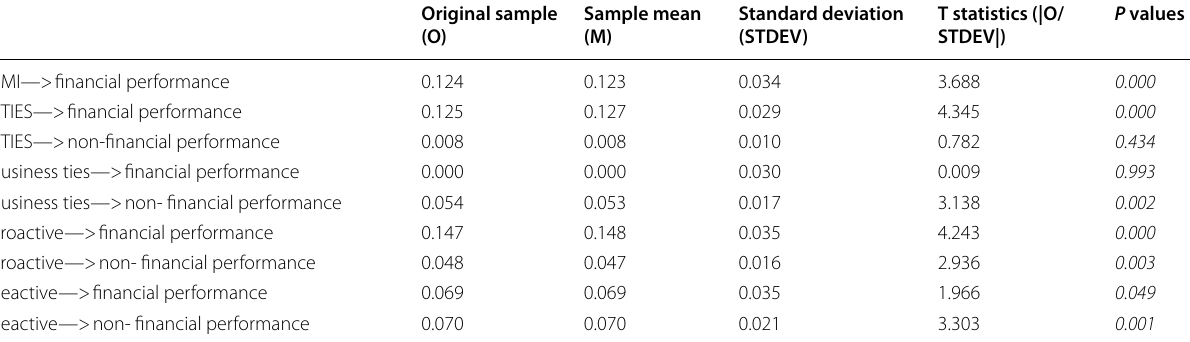
Table 4 Indirect relationships